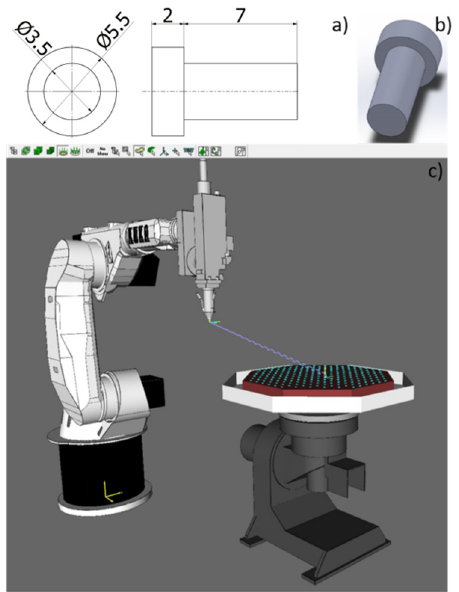
Figure 1. ( a ) The technical drawing of the 3D metallic implant; ( b ) the 3D drawing of the implant; ( c ) the TruTops Cell ® graphical software which generates the movement codes for the robotic arm.